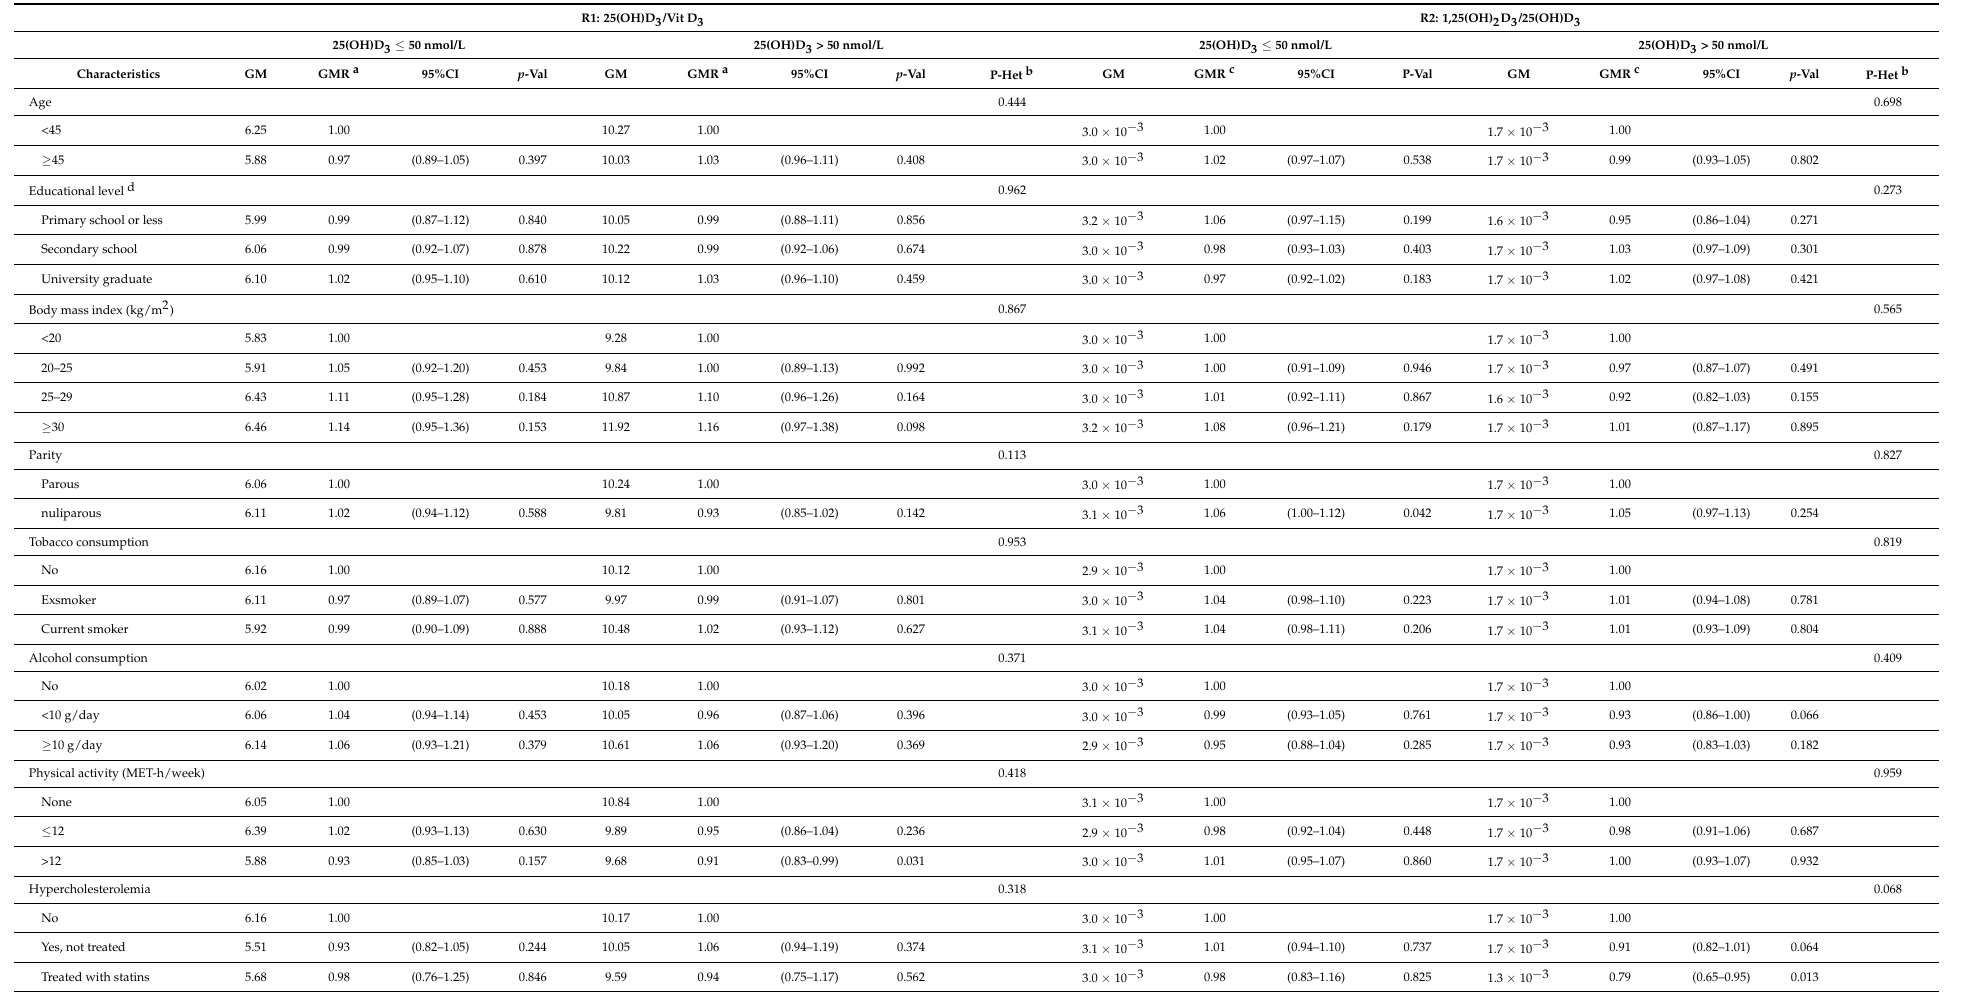
Table 4. Association between R1 and R2 metabolite ratios and characteristics of women according to vitamin D